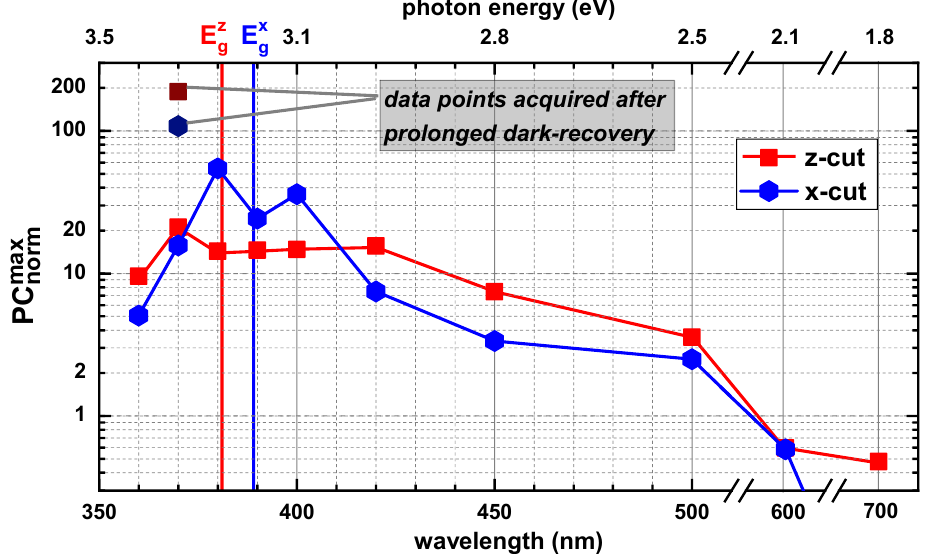
Figure 5. Semi-logarithmic overview of the normalized PC achieved after a 60 min illumination period (averaged over the last 10 min of this 60 min illumination interval) for all selected wavelengths and for both crystal cuts. Note that the value at 700 nm for the x-cut was omitted, because it might not be reliable, since the maximum PC is not achieved after 60 min in that case, but earlier (cf. Figure 4e). The two darker colored data points (recorded at 370 nm) indicate much higher PC values and were acquired after a one-week- instead of a 20-h dark